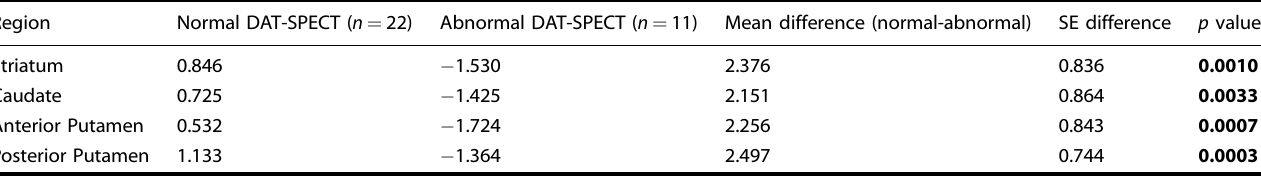
Table 2. Regional differences in DAT-SPECT uptake between those with normal and abnormal